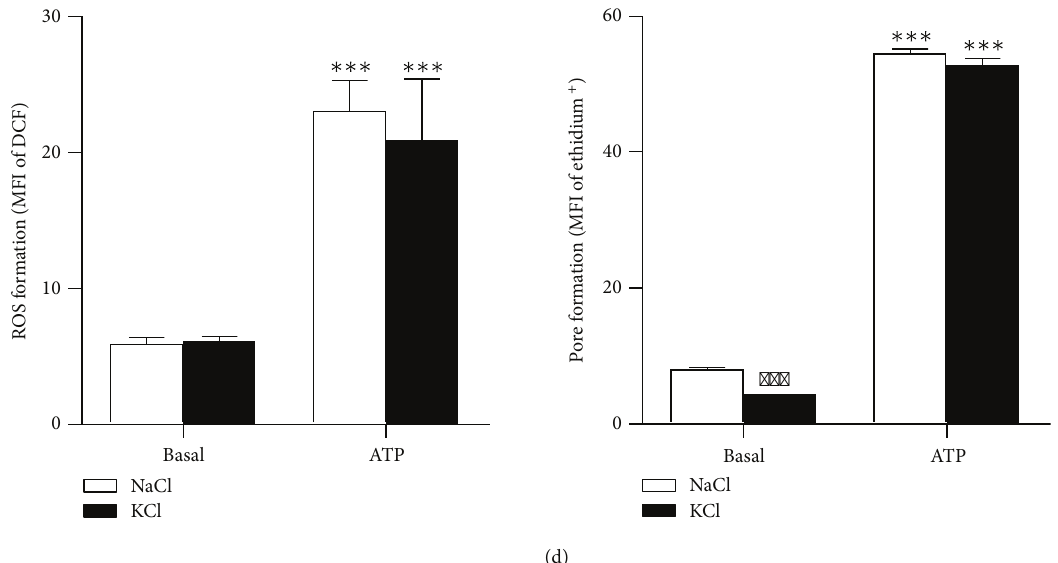
(preincubated in the absence (control) or presence of 10